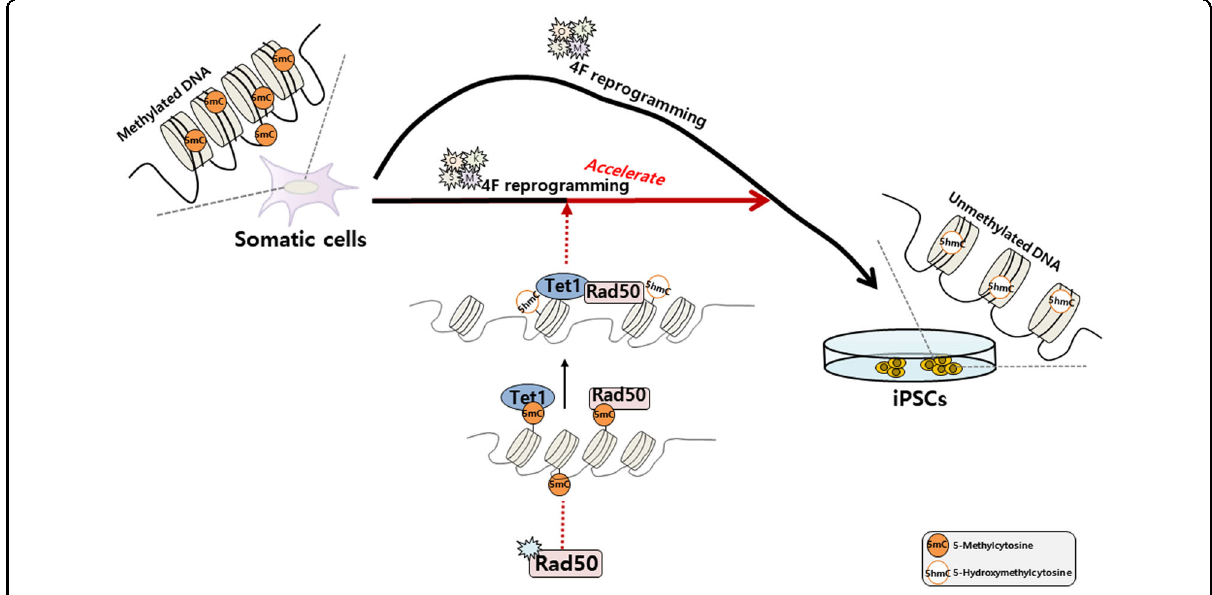
Fig. 6 Schematic representation of Rad50 enhancement of somatic cell reprogramming. The interaction between Rad50 and Tet1 forms a positive feedback loop in the regulation of demethylation, which could enhance somatic cell